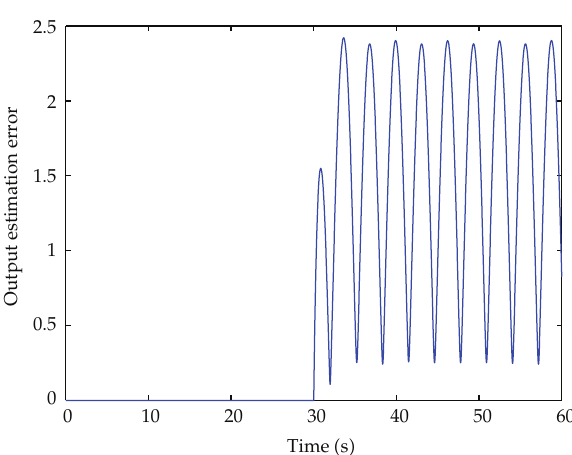
Figure 3: Output estimation error in case 2 using a high frequency